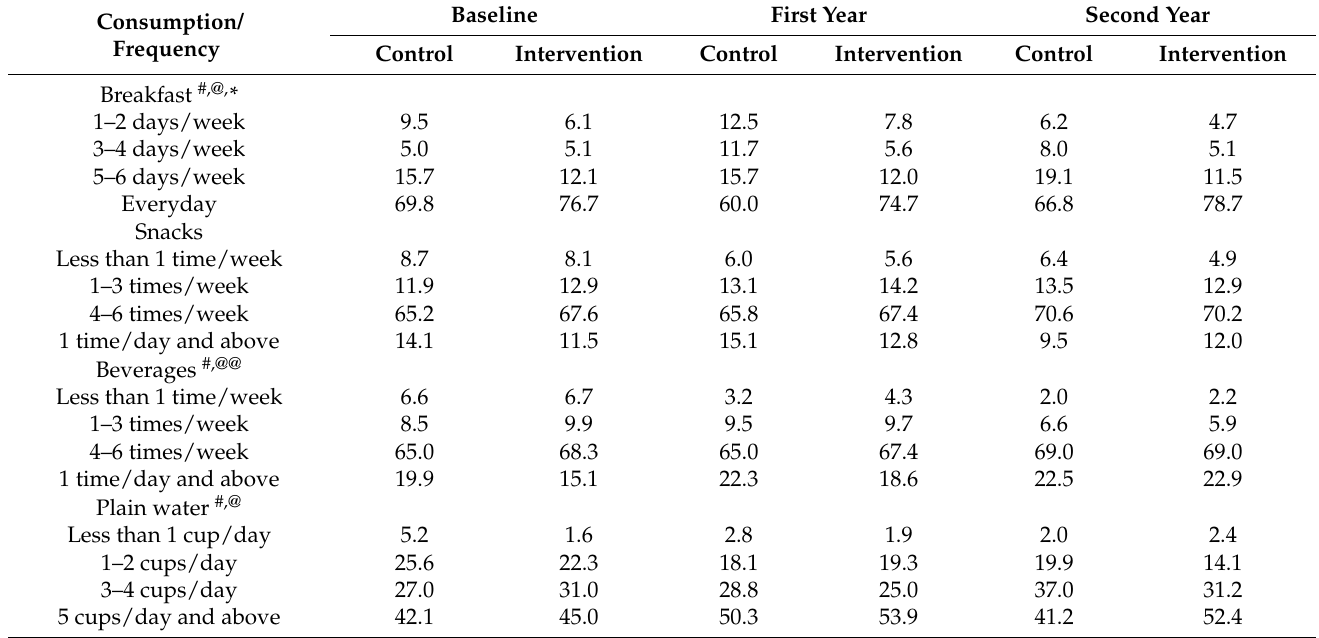
Table 7. Comparison of the frequency of breakfast, snack, beverage, and plain water consumption of children in the past week between the intervention group and control group (%).